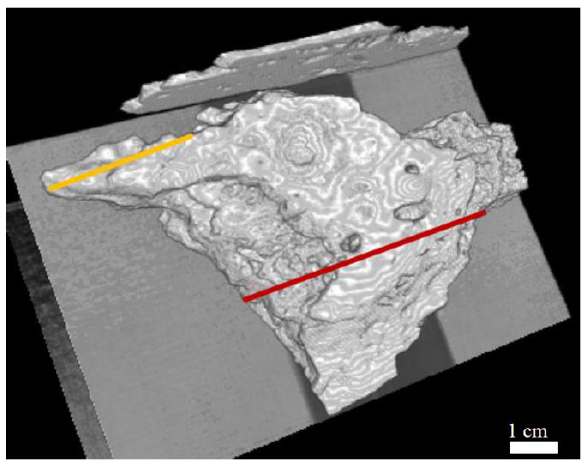
Figure 5. Volume reconstruction of sample B based on X-ray tomography.